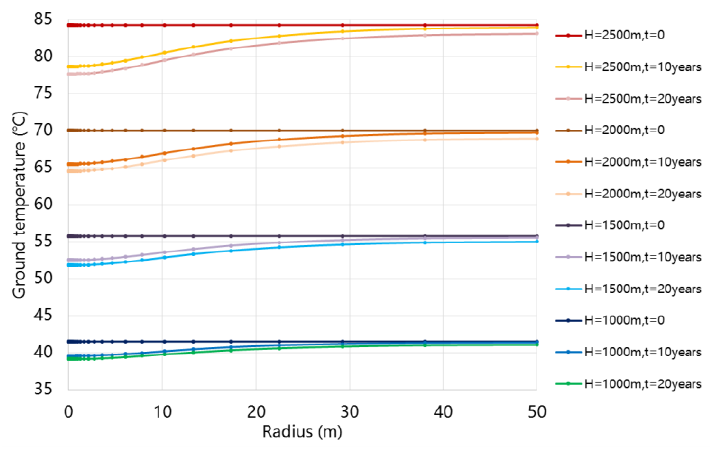
Figure 27. Ground temperature variation after 20-years of